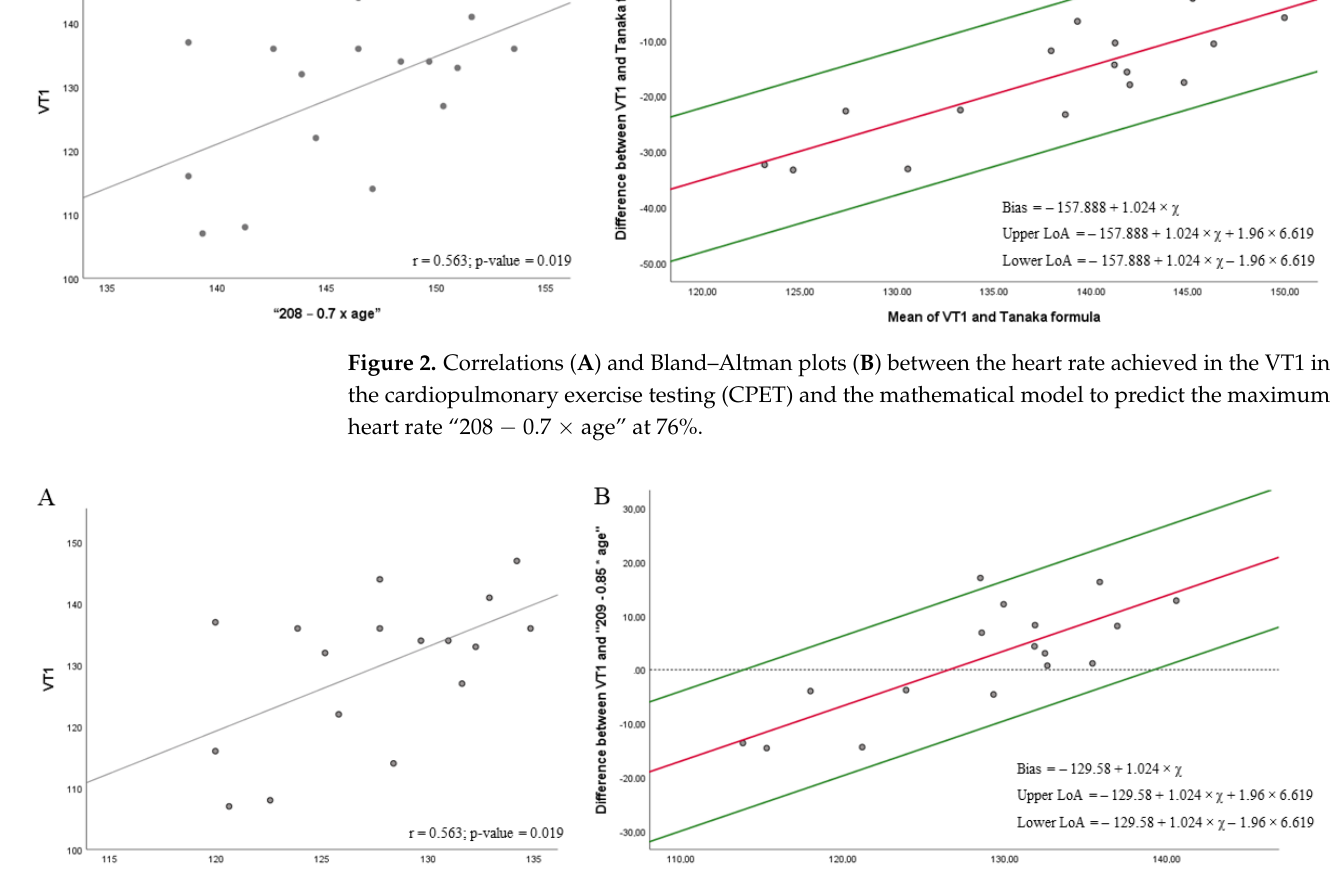
Figure 4. Correlations ( A ) and Bland–Altman plots ( B ) between the heart rate achieved in the VT1 in the cardiopulmonary exercise testing (CPET) and the Karvonen Formula at 60%. Figure 2 shows a moderate correlation between the heart rate at VT1 and “208 − 0.7 × age” at 76% HRmax (r = 0.563; p = 0.019) (Figure 2A). Regression showed a significant proportional bias ( p ‐ value < 0.001), then, Bland ‐ Altman plot was depicted according to the regression results. Results from t ‐ test (Figure 2B) did not show a significant agreement between heart rate at VT1 and the “208 − 0.7 × age” formula [20] at 76% HRmax (bias = − 157.888 + 1.024 × x ; 95% LOA = − 157.888 + 1.024 × x + 1.96 × 6.619 to − 157.888 + 1.024 × x − 1.96 * 6.619, where x is the average between the heart rate obtained in the CPET at VT1 and “208 − 0.7 × age”, in this case 136.66; p < 0.001). The proportional bias indicated that heart rate obtained in CPET is higher than that obtained in mathematical model. Figure 3 shows a moderate correlation between the heart rate at VT1 and “209 − 0.85 × age” at 76% HRmax (r = 0.563; p = 0.019) (Figure 3A). Regression showed a significant proportional bias ( p ‐ value < 0.001), and then the Bland–Altman plot was depicted accord ‐ ing to the regression results. Results from the t ‐ test (Figure 3B) showed significant agree ‐ ment between the heart rate at VT1 and the “209 − 0.85 × age” formula at 76% HRmax [13] (bias = − 129.58 + 1.024 × x ; 95% LOA = − 129.58 + 1.024 × x + 1.96 × 6.619 to − 129.58 + 1.024 × x − 1.96 × 6.619, where x is the average between the heart rate obtained in the CPET at VT1 and “209 − 0.85 x age”, in this case 127.30; p = 0.403). However, the proportional bias indi ‐ cated that the heart rate obtained by CPET was higher than that obtained in the mathe ‐ matical model. In addition, one measure exceeded the LOA.